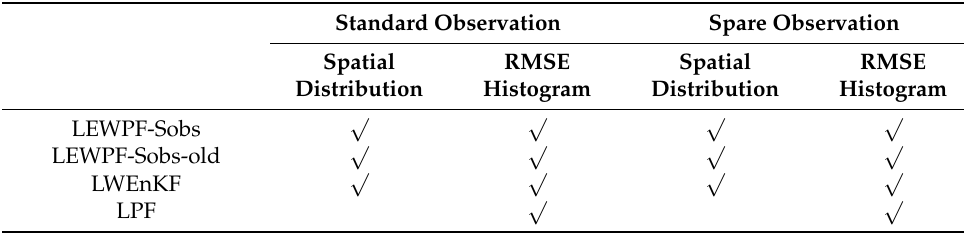
Table 1. The experimental